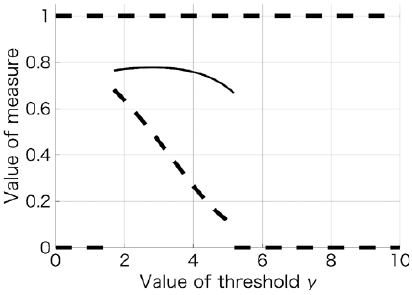
Figure 4: CBC and bounds (when pr ( x 1 ) = 0 . 67; the CBC is represented by solid lines, and the upper and lower bounds are represented by dotted